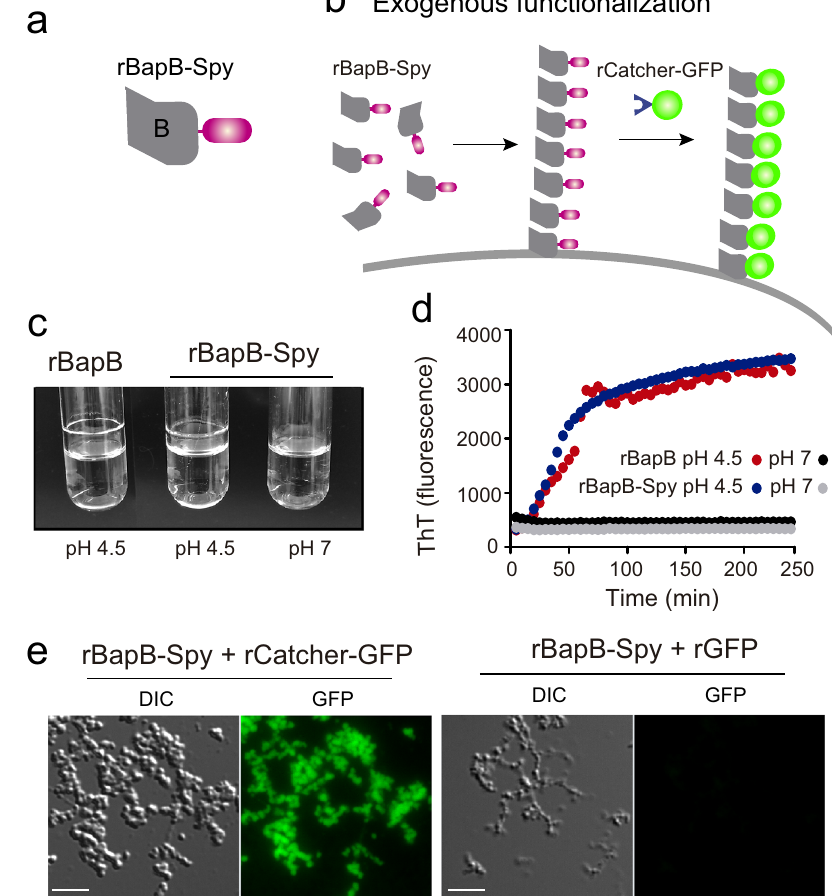
Fig. 7 Recombinant rBapB-Spy protein forms aggregates under acidic conditions that can be functionalized with rCatcher-GFP. Schematic illustration showing a rBapB-Spy and b functionalized fi bers after exogenous complementation with rBapB-Spy. c rBapB-Spy aggregates under acidic conditions in a similar way of rBapB. 2 μ M of puri fi ed recombinant proteins (rBapB-Spy and rBapB) were incubated in phosphate-citrate buffer at pH 4.5 and pH 7. Aggregates were only visible at acid pH. d rBapB-Spy and rBapB aggregation kinetics were monitored by following the changes in relative ThT fl uorescence emission intensity. e Immuno fl uorescence showing rBapB-Spy aggregates probed with puri fi ed recombinant rCatcher-GFP and puri fi ed rGFP alone (used as a control). The fl uorescence of GFP and the differential interference contrast (DIC) images are shown. Scale bar of panels represents 5 μ